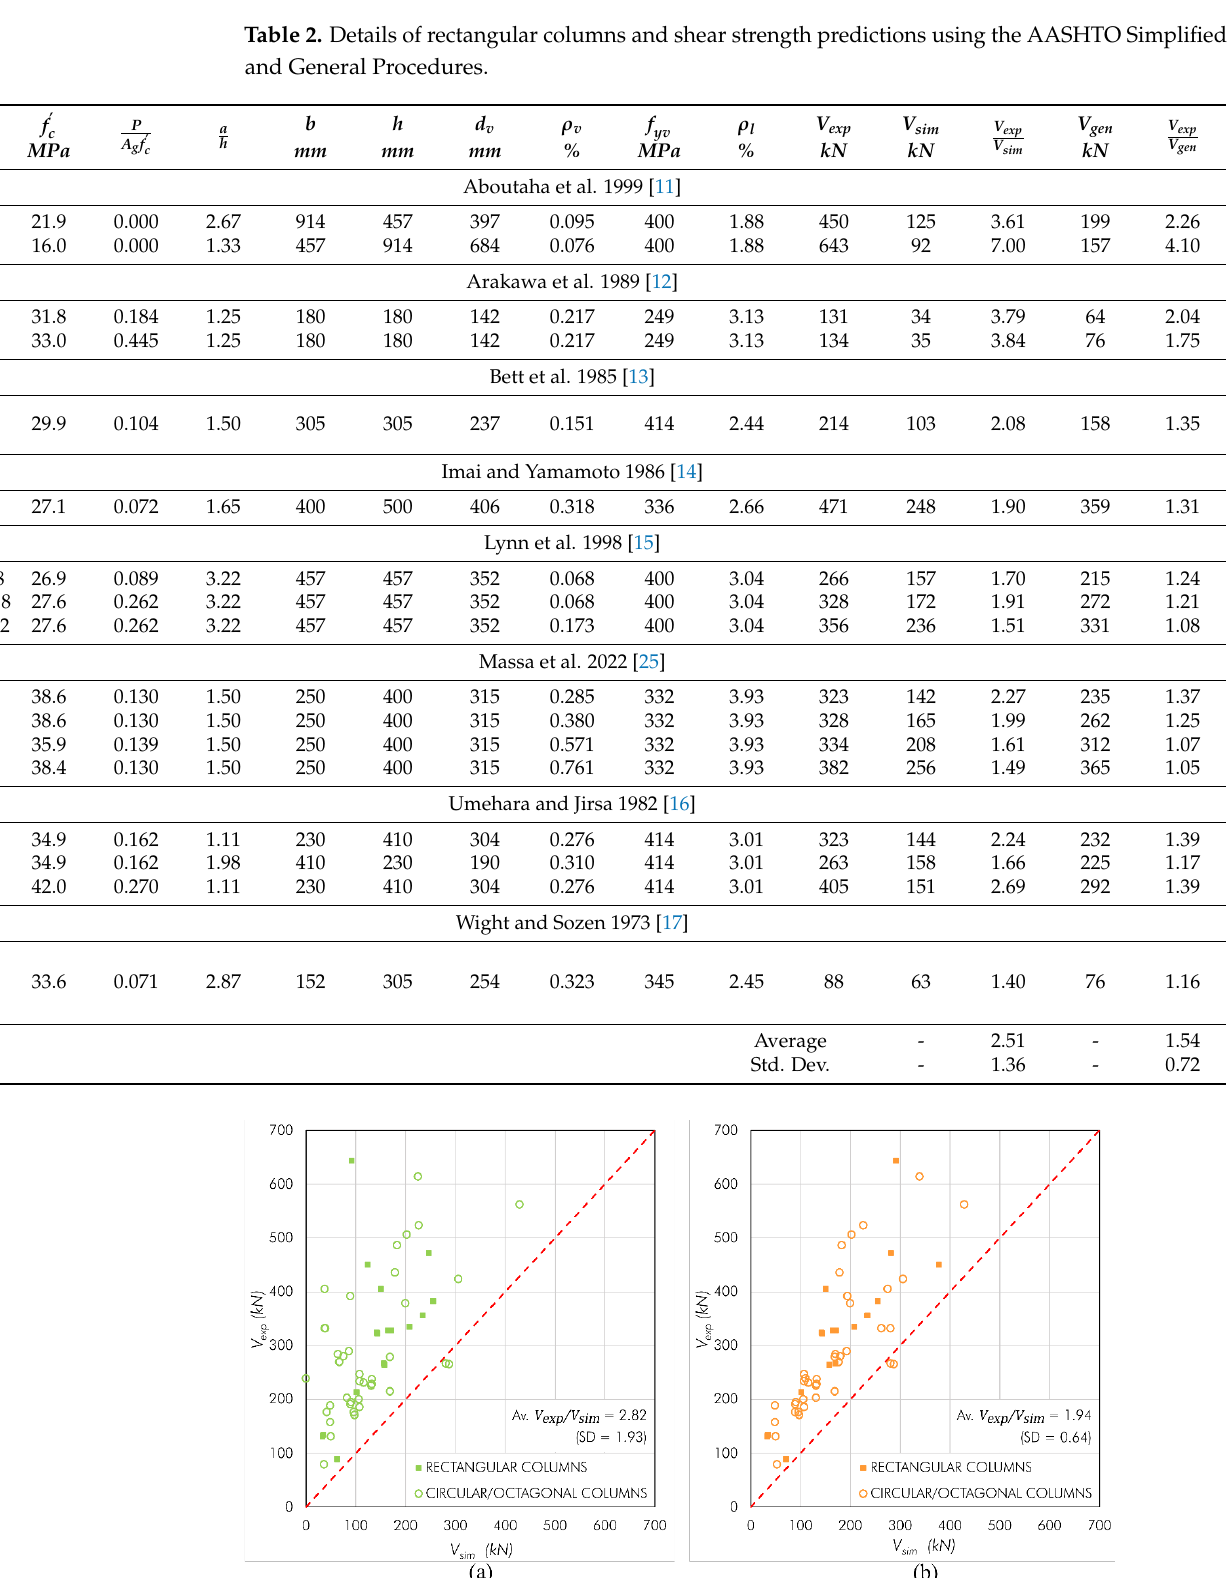
Figure 4. Shear strength predictions of rectangular, circular, and octagonal columns using the AASHTO General Procedure: ( a ) With reduction in 𝑉 𝑐 for low axial load levels; ( b ) Without reduction in 𝑉 𝑐 . It is noted that many of the columns tested have small shear span-to-depth ratios, 𝑎/𝐷 or 𝑎/ℎ (see Figures 1 and 2). These members that are subjected to an axial compressive load can develop an inclined compressive strut which helps to resist the shear along with the sectional shear resistance [26,27]. The sectional model predictions shown in Figure 3 do not include the beneficial influence of a compressive strut for columns with low 𝑎/𝐷 or 𝑎/ℎ ratios and hence in some cases these predictions can be overly conservative. The predictions that are most conservative shown in Figure 3 are columns with very low shear span-to-depth ratios. These columns acted as wall-type piers and displayed strut action as indicated by the cracking pattern observed in the tests. For